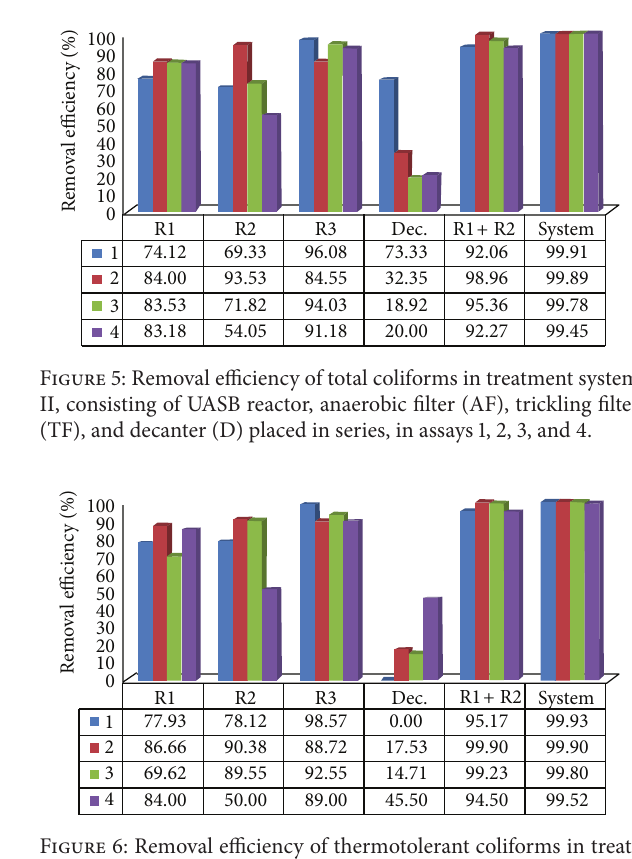
Figure 4: Removal efficiency of thermotolerant coliforms in the UASB reactors (R1 and R2) placed in series, at pilot scale, for treatment system I, in assays 1, 2, 3, and 4.